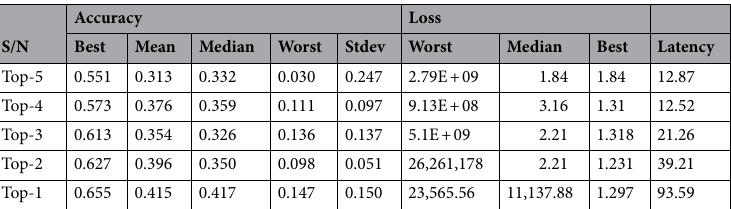
Table 10. Performance comparison for training the five (5) best performing CNN architectures from EOSA- NAS algorithm using mean, median, accuracy and standard deviation for accuracy, and loss, computation time values for the 250 epochs of EOSA.